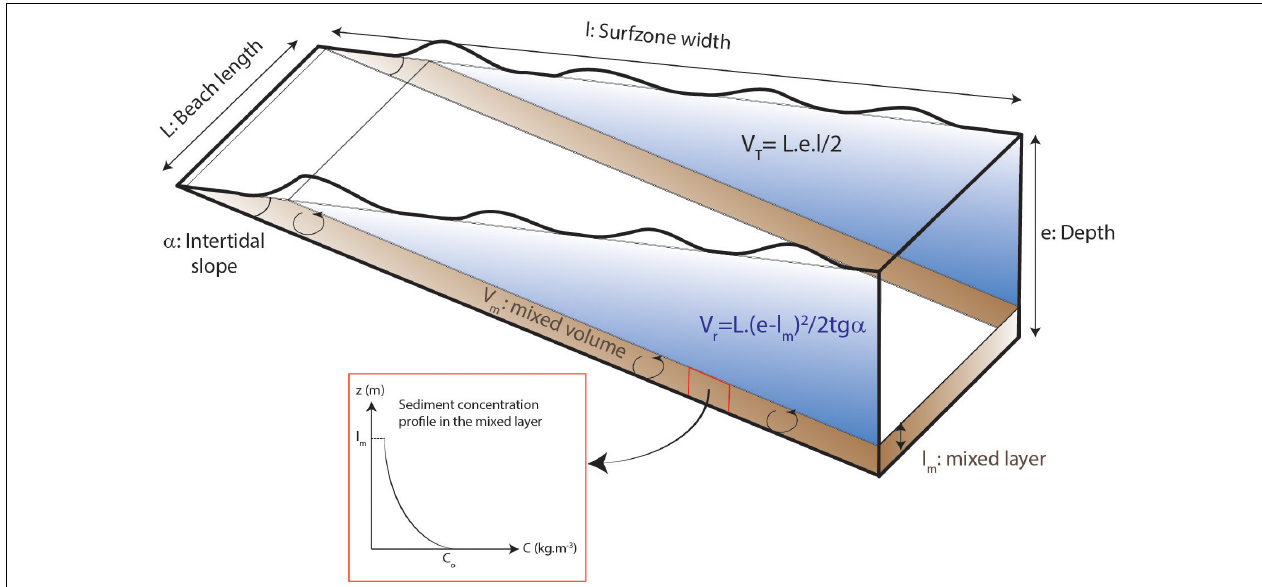
FIGURE 4 | Simplified geomorphological model of sandy beach used for the Si flux calculations. Numerical values of the various parameters are summarized in Tables 3 , 4 . Sediment is agitated by the waves only into the mixed layer (shaded brown) and the sediment concentration decreases exponentially form the bottom to the top of this layer. V T is the total volume of water, V r is the volume of water devoid of sediment, and V m is the volume containing the agitated sediment.